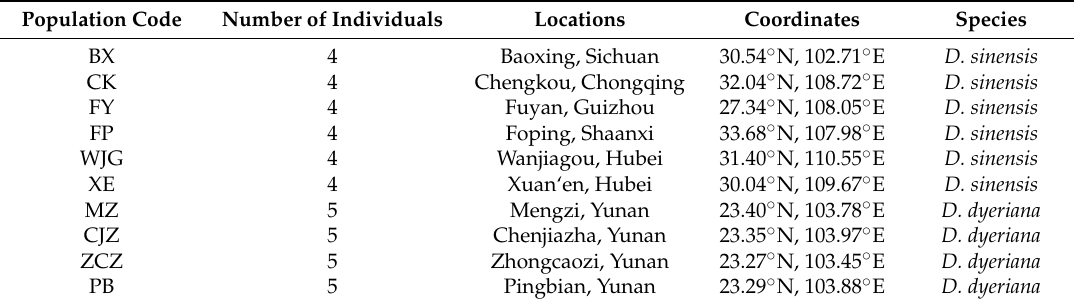
Table 4. The information of 10 different populations used in genetic diversity analysis.